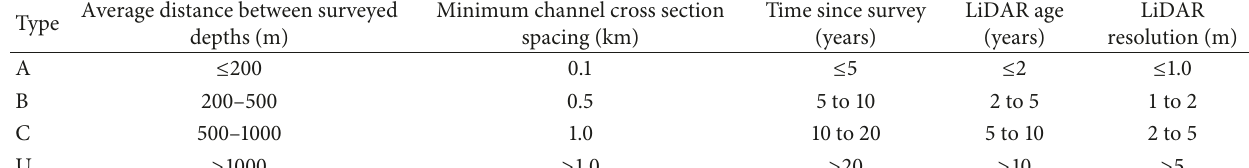
Table 1: Bathymetry and topographic data requirements for models (A � design; B � appraisal; C � strategy; and U � unsatisfactory); from Defra/EA [3].